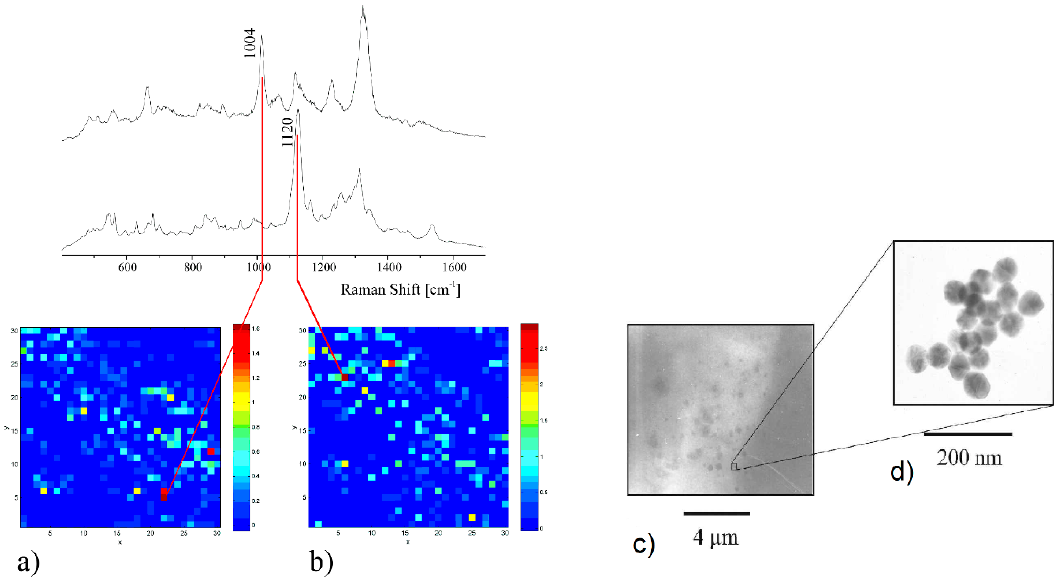
Figure 47. Example of SERS imaging. Distribution of the maximum Raman signal of phenylalanine, Phe– at 1004 cm − 1 ( a ) and DNA, O–P–O DNA backbone at 1120 cm − 1 ( b ) over a 30 × 30 mm 2 cell. The maximum of the two Raman signal occurs at different places considering that DNA is mainly located in the cell nucleus, while phenylalanine should be mainly present in the cytoplasm. Electron micrograph of Au nanoparticles inside a cell ( c ). Magnification showing 60-nm gold colloidal sphere aggregates ( d ). Reproduced with permission from Kneipp et al. [453]. Copyright (2002), Society for Applied Spectroscopy.